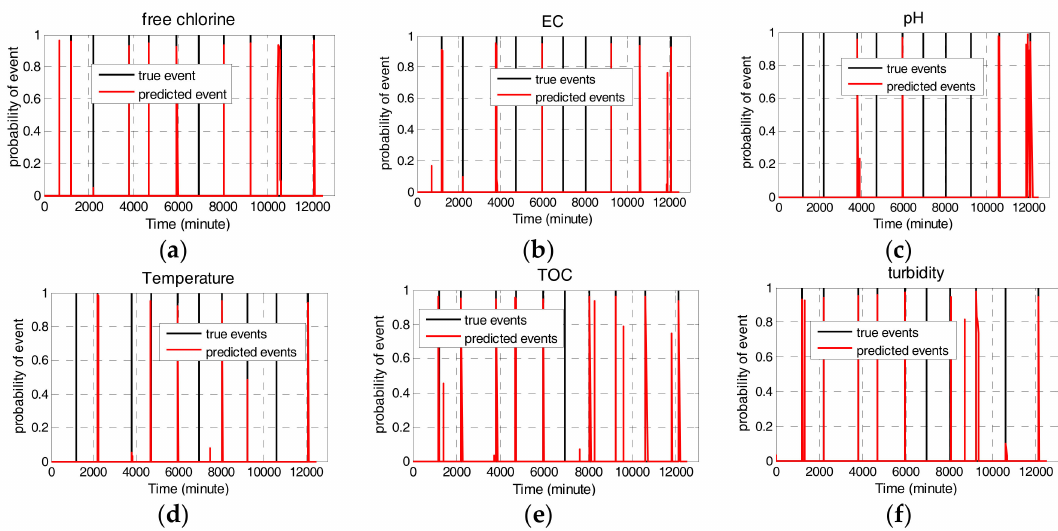
Figure 5. Event probability of single water quality parameter. ( a ) free Chlorine; ( b ) EC; ( c ) pH; ( d ) Temperature; ( e ) TOC; ( f )